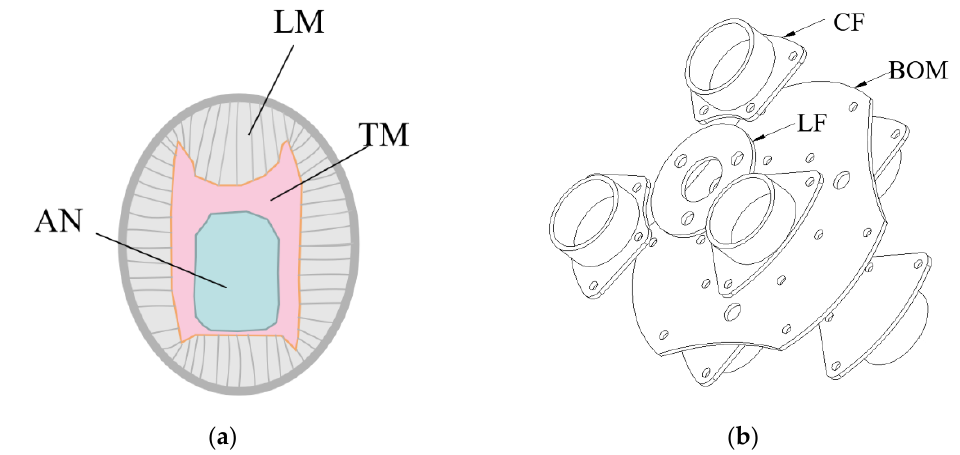
Figure 1. Design of the connecting plate: ( a ) sectional musculature of an octopus arm; ( b ) 3D image of a flexible connecting plate.